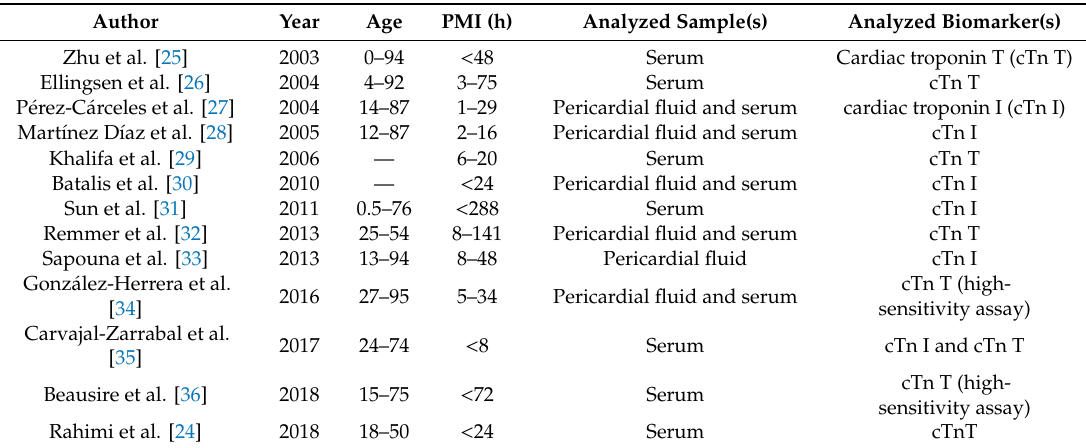
Table 1. The characteristics of the included